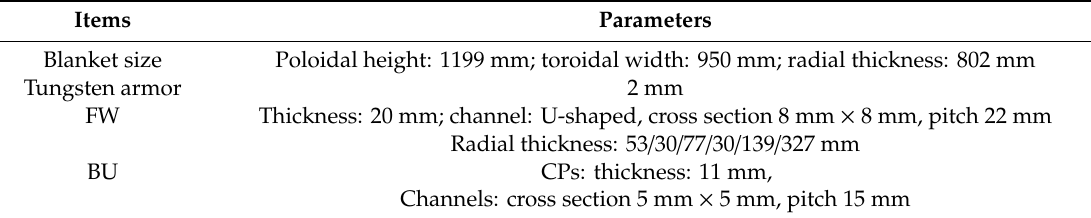
Table 5. Main parts dimensions of the WCCB blanket #3 module.